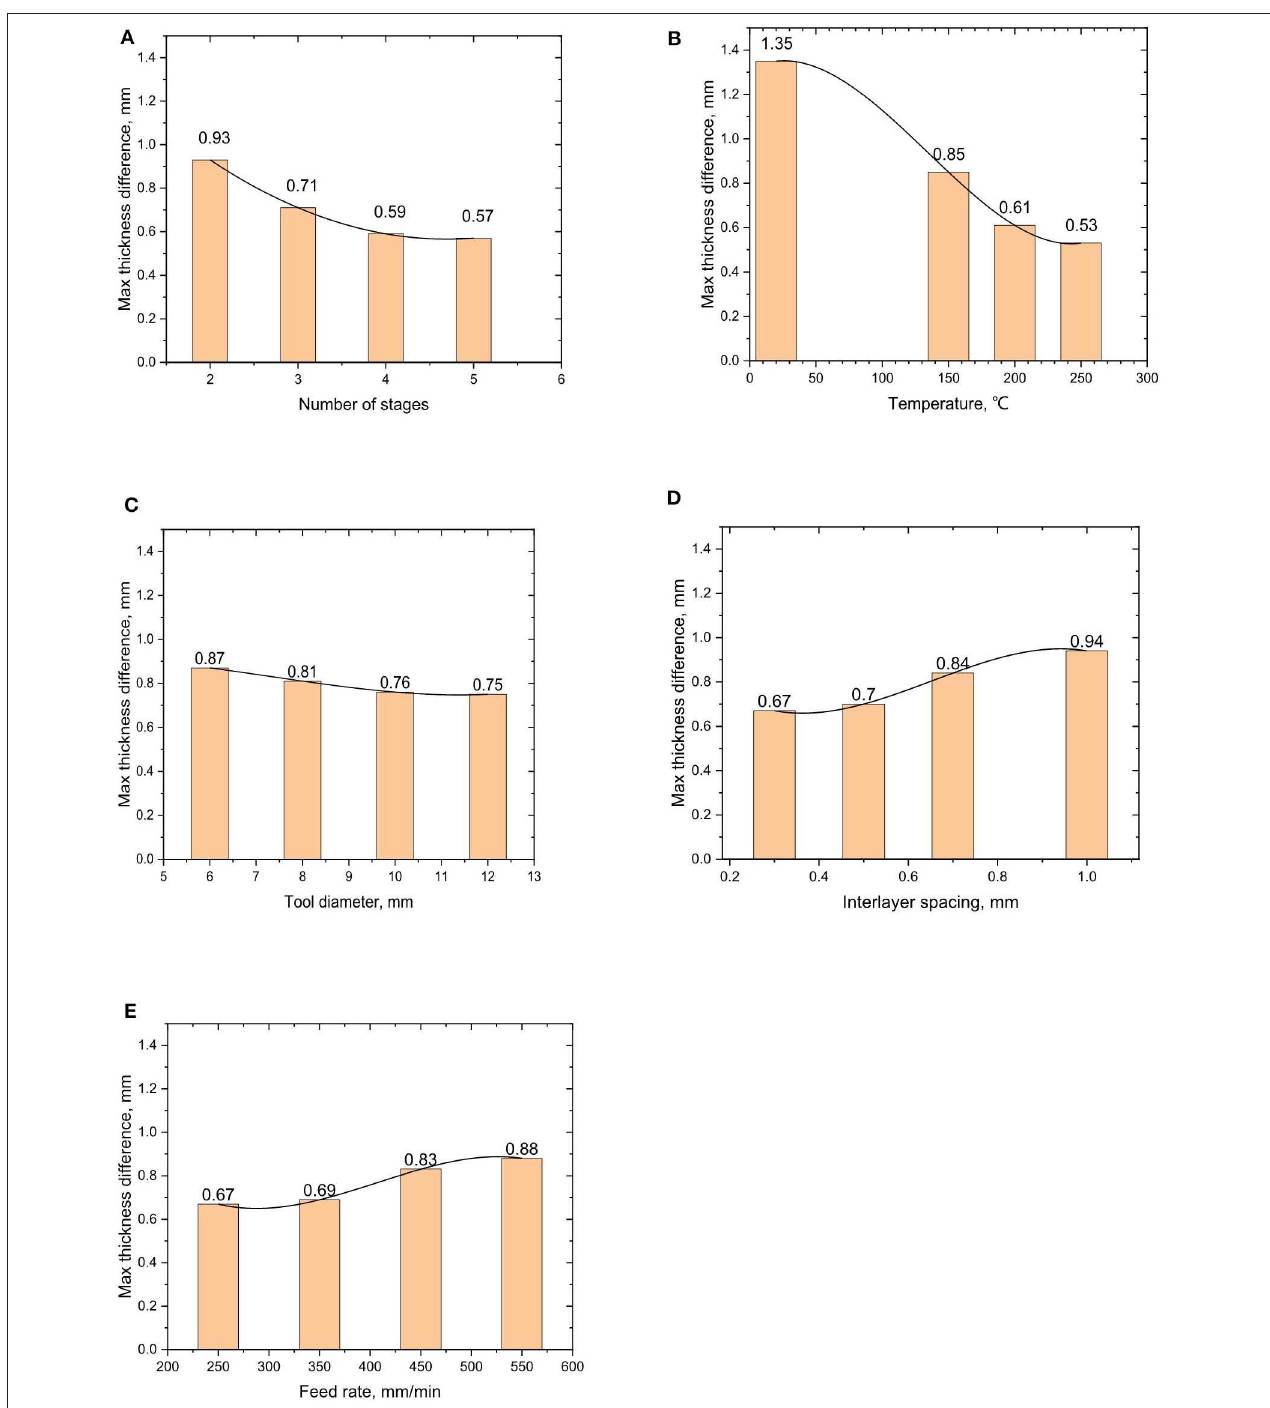
FIGURE 10 | Relationship curves between maximum thickness difference and process parameters: (A) the influence of forming stage number on wall thickness uniformity of formed parts; (B) the influence of temperature on wall thickness uniformity of formed part; (C) the influence of forming tool head diameter on wall thickness uniformity of formed part; (D) the influence of interlayer spacing on wall thickness uniformity of formed parts: (E) the influence of feed rate on wall thickness uniformity of formed part.